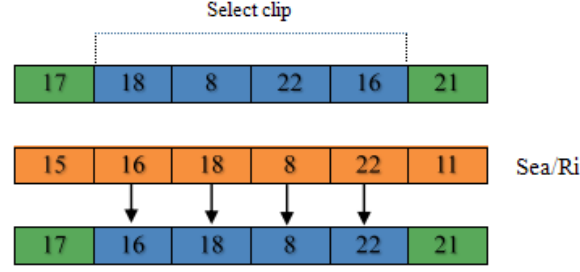
Figure 2. First type of confluence update.